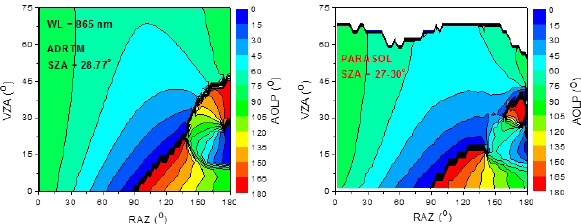
Figure 16. Comparison of the modeled AOLP of desert-reflected solar light with those from the PARASOL data at the wavelength of 865nm. The SZA is 28.77 ◦ in the modeling. The SZA is in the bin of 27–30 ◦ for the PARASOL data.